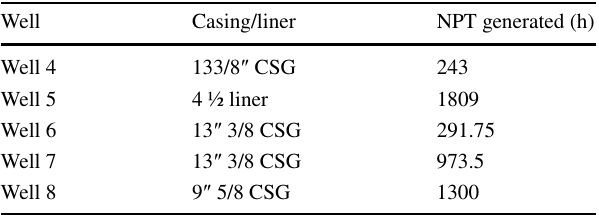
Table 2 Nonproductive time due to flash setting